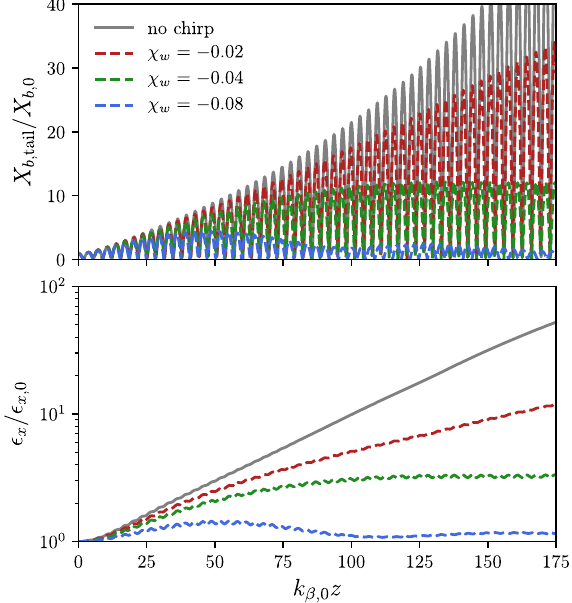
FIG. 8. PIC simulation results for beams with differing values of the relative chirp. The beams are initially misaligned with respect to the propagation axis of the drive beam and are subject to hosing. Centroid deviations at the tail of beams (top) and respective projected rms emittance